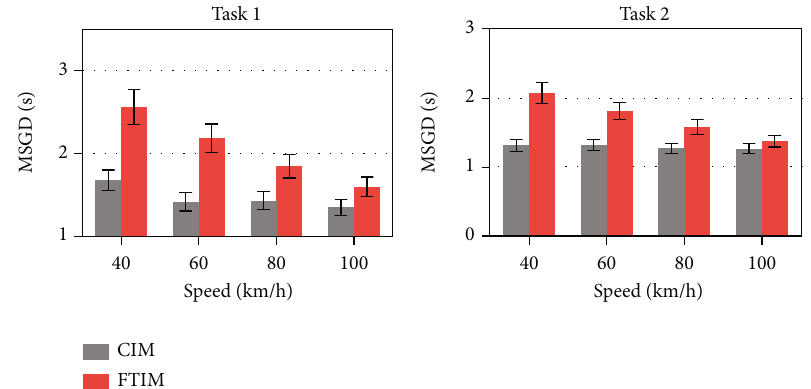
Figure 10: MSGD for HMI by interaction mode and speed during the tasks.